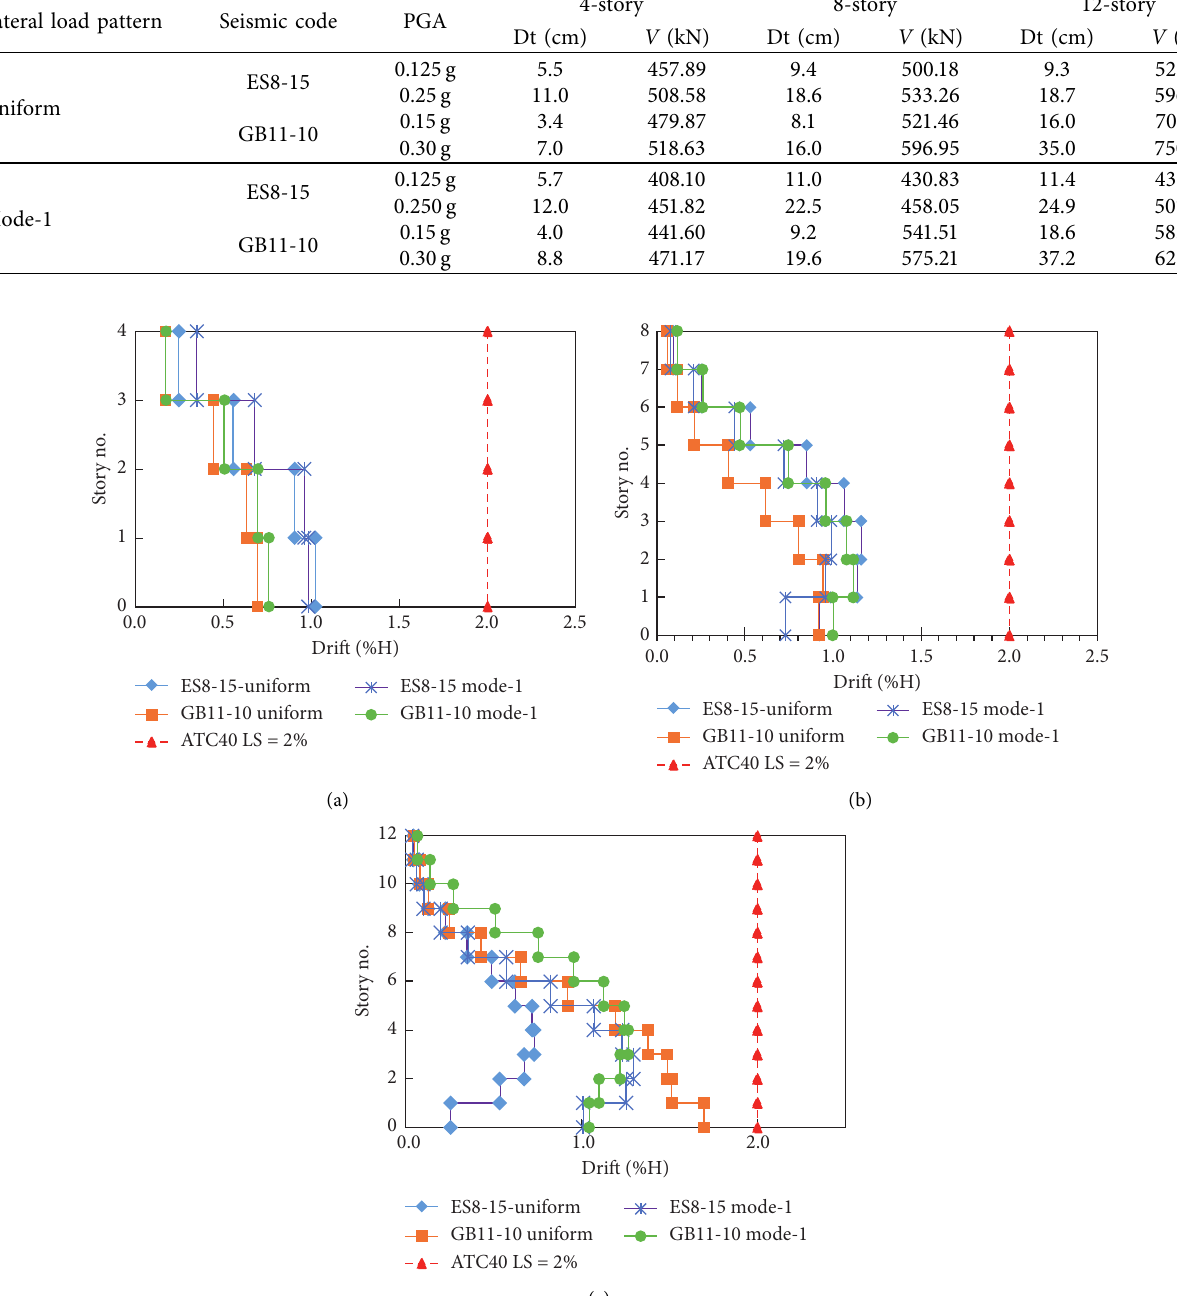
Table 6: Target displacements and base shear calculated using the capacity spectrum method ATC